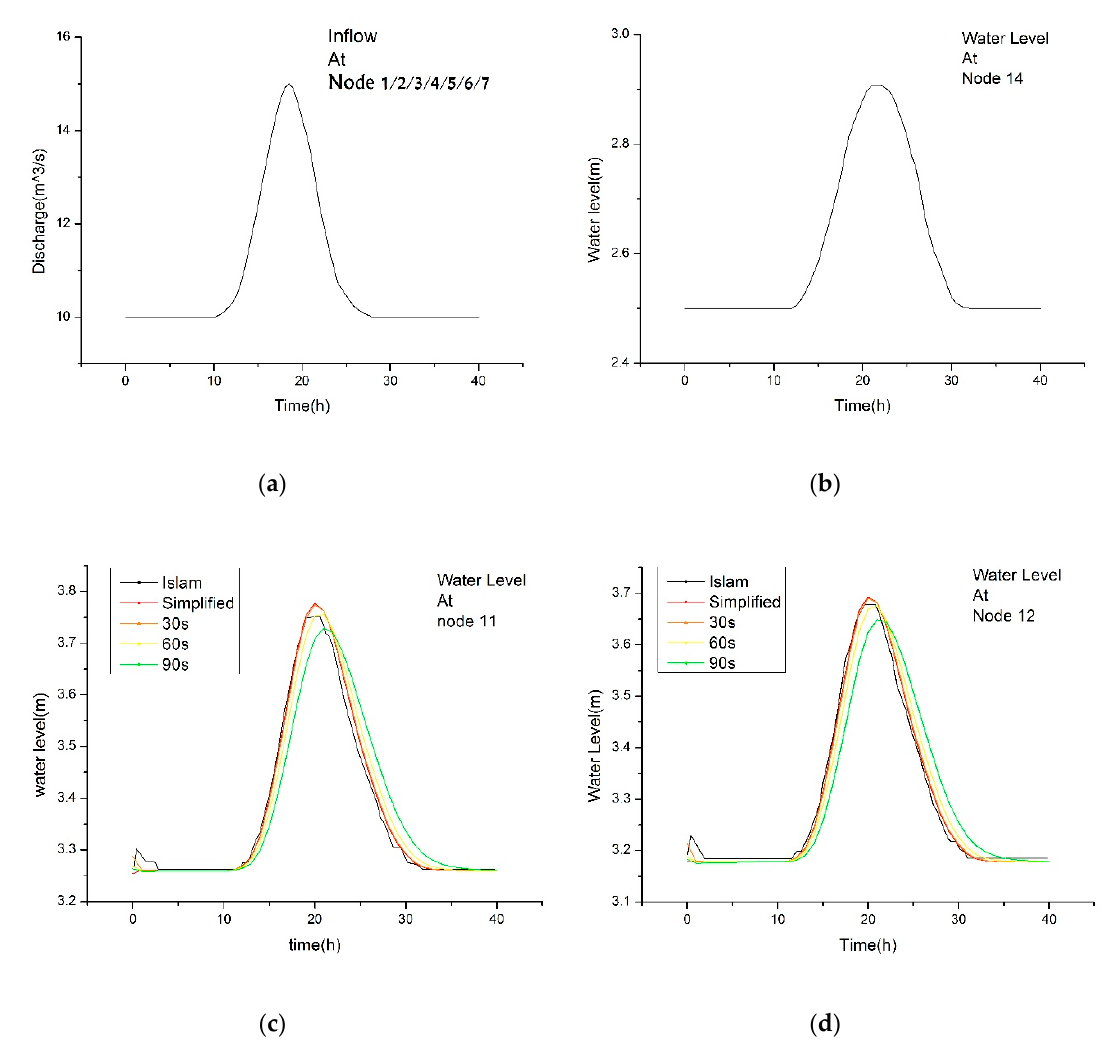
Figure 7. Boundary conditions and results of loop network 2: ( a ) inflow discharge on the left side, ( b ) water level on the right side, ( c ) water level at node 11, and ( d ) water level at node 12. Table 3. Water level error